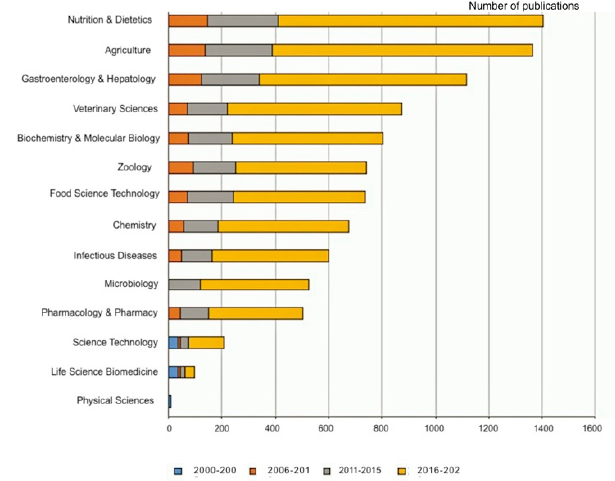
Figure 2. Distribution of publications among the most studied research areas.